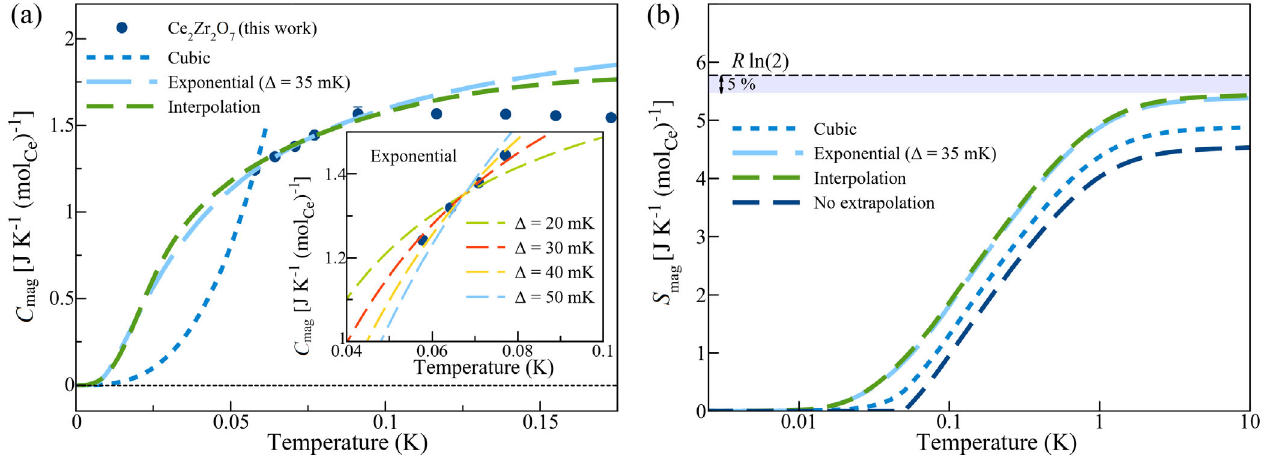
FIG. 17. (a) The best-fitting naive cubic and exponential extrapolations to the measured C data, as well as the low temperature mag at sufficiently low temperature, as described in the text. extrapolation which is consistent with the NLC fit for T > ∼ 0 . 5 K and a T 3 C mag A simple best-fitting cubic extrapolation forms a sharp cusplike connection with the data while the simple best-fitting exponential extrapolation and the interpolation (as discussed in the text) both run smoothly through the lowest-temperature data points. The inset of (a) shows the simple exponential extrapolations for different values of the gap energy. Such an analysis yields an estimate of Δ ¼ R 35 ð 5 Þ mK for the gap energy. (b) A comparison of the entropy recovered via S T 0 ð C mag =T Þ dT using the different low temperature mag ¼ extrapolation schemes of C that are shown in mag